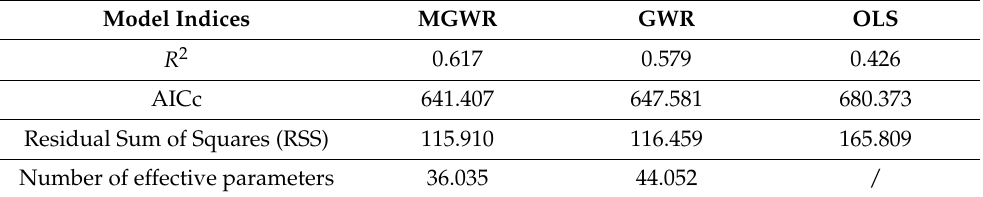
Table 3. Comparison of OLS, GWR, and multiscale geographical weighted regression (MGWR) model